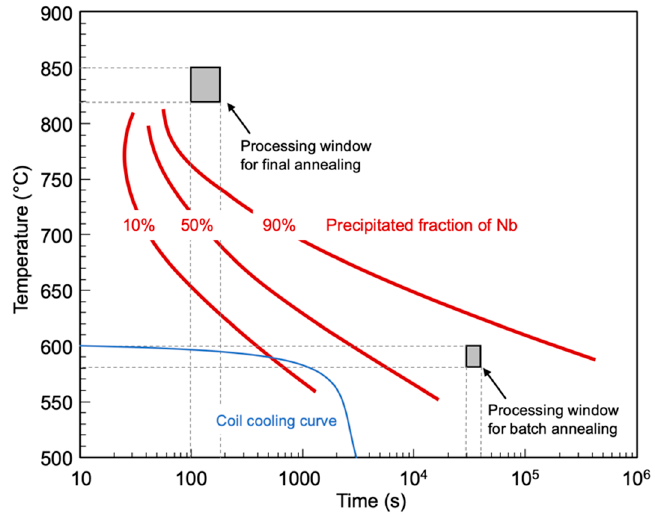
Figure 11. Precipitation kinetics of niobium in the ferrite phase; various time-temperature scenarios applied during processing of DP steel in the current study are indicated.